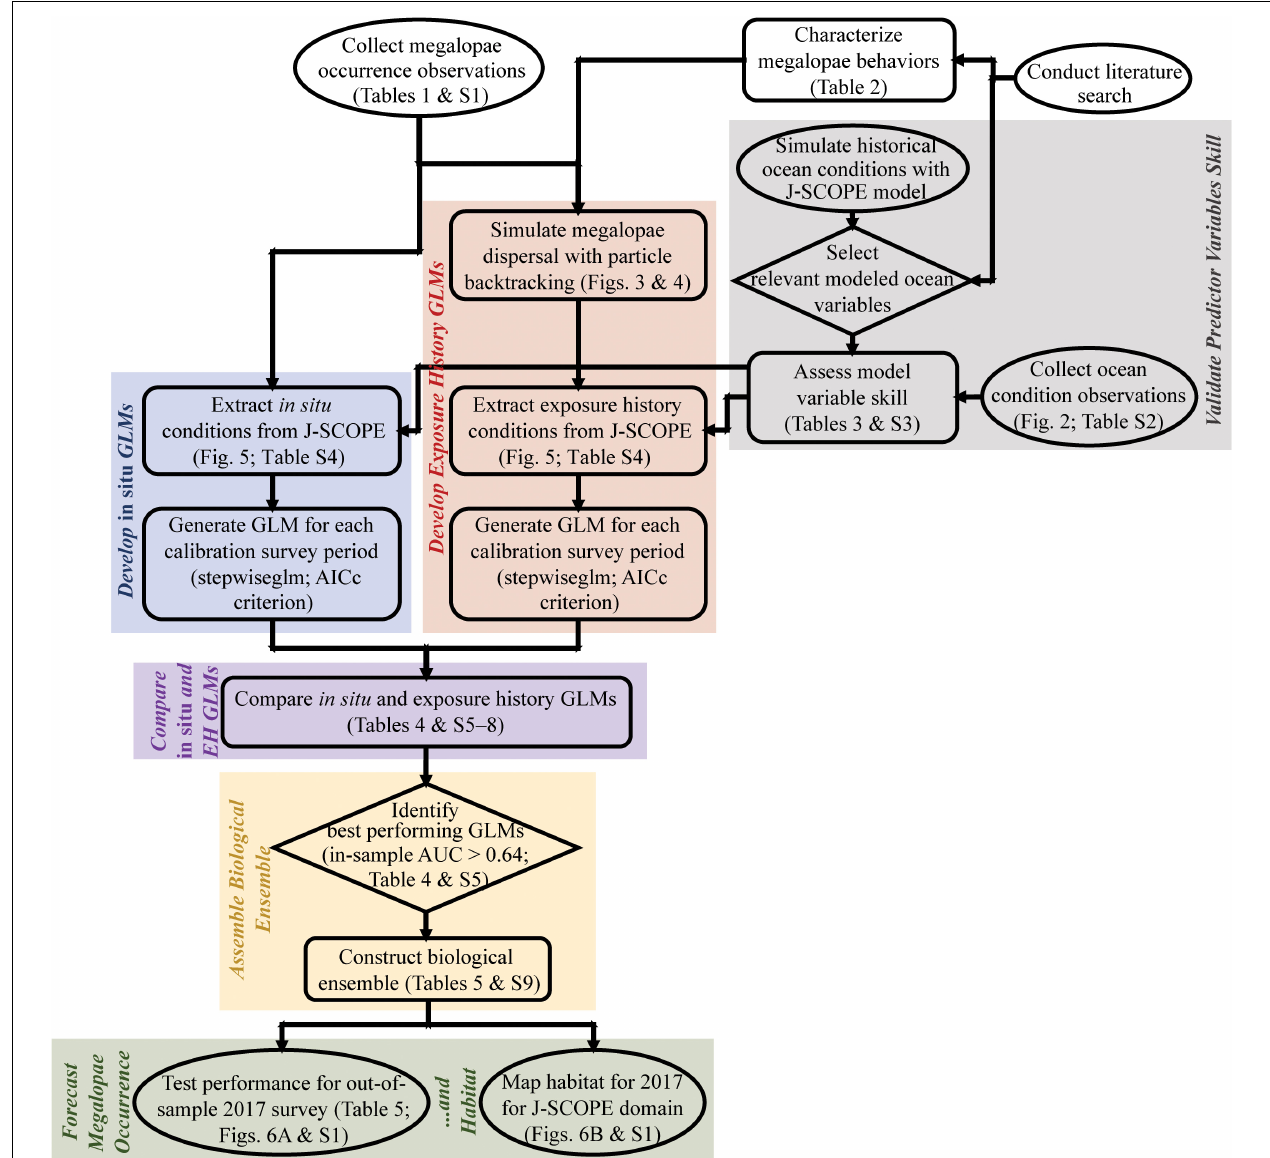
FIGURE 1 | Flowchart summarizing the main methods and results of this paper, including validation of predictor variables skill (gray); development of in situ (blue) and exposure history (red) generalized linear models (GLMs); comparison of in situ and exposure history GLMs (purple); assembly of the biological ensemble (yellow); and forecasting of megalopae occurrence and habitat (green). Start and end nodes are in ovals, process steps are in boxes, and decision points are in diamonds. Table SX refers to Supplementary Tables (1–9) . AICc = Akaike information criterion corrected for small sample size; AUC = area under the receiver operating characteristic (ROC) curve; EH = exposure history; GLM = generalized linear model; J-SCOPE = JISAO’s Seasonal Coastal Ocean Prediction of the